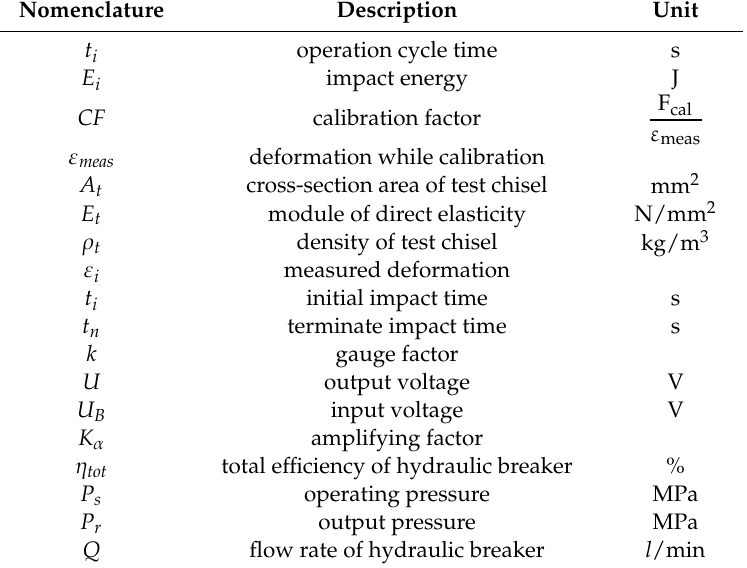
Table 4. Description of variables.